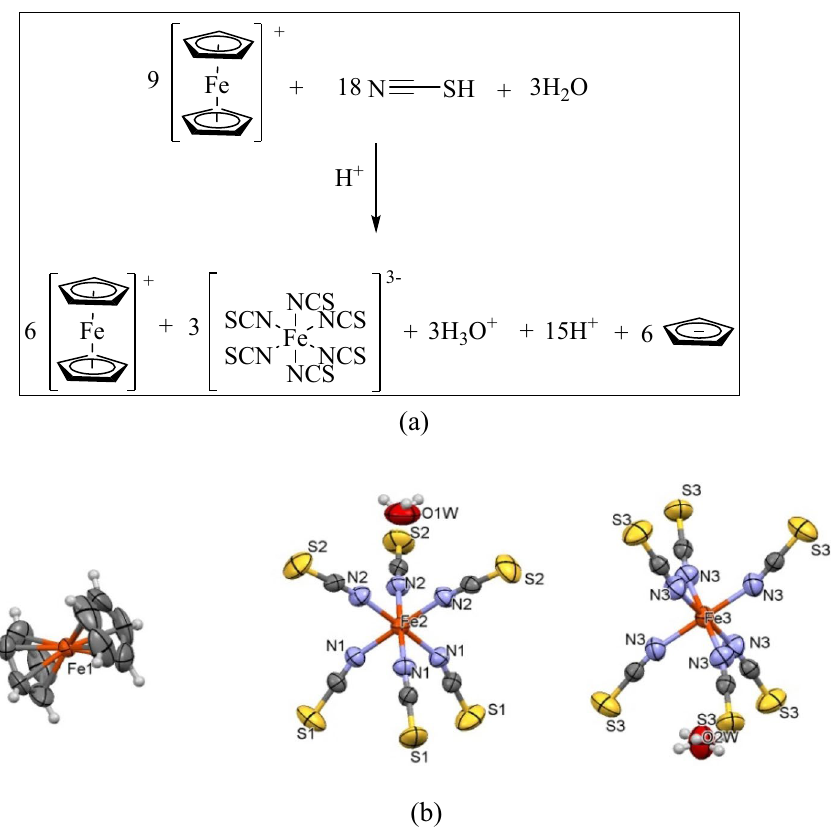
Figure 3. ( a ) Structure of HexaFc, ( b ) HexaFc crystal structure with 30% ellipsoid probability at